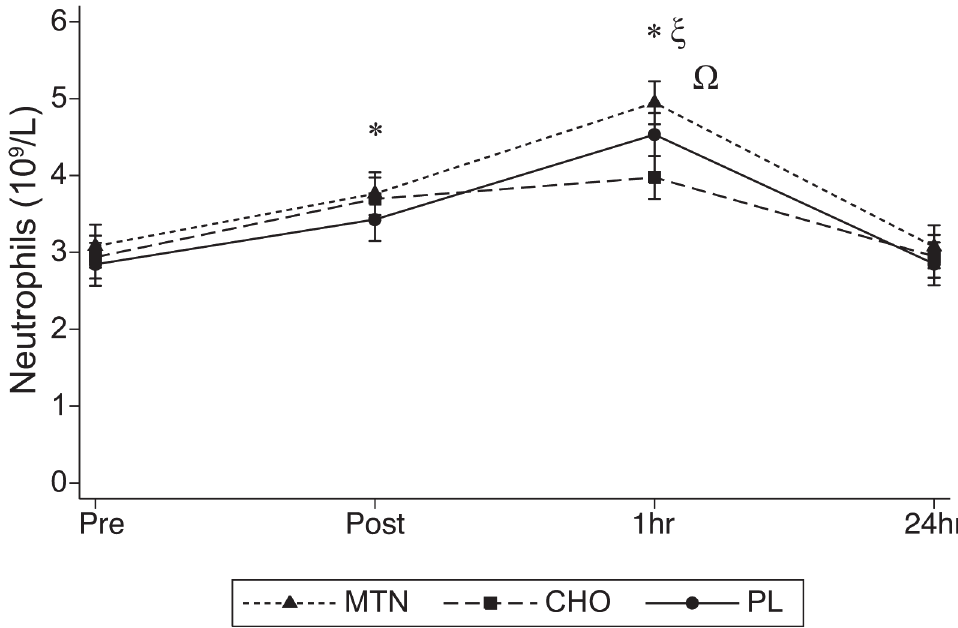
Fig 4. Neutrophil counts determined at all times points for the three tested conditions. * p < 0.05 from post and 1h to pre for CHO and PL; ξ p < 0.01 from 1h to pre for MTN and placebo; Ω p < 0.05 at 1h after exercise from MTN to